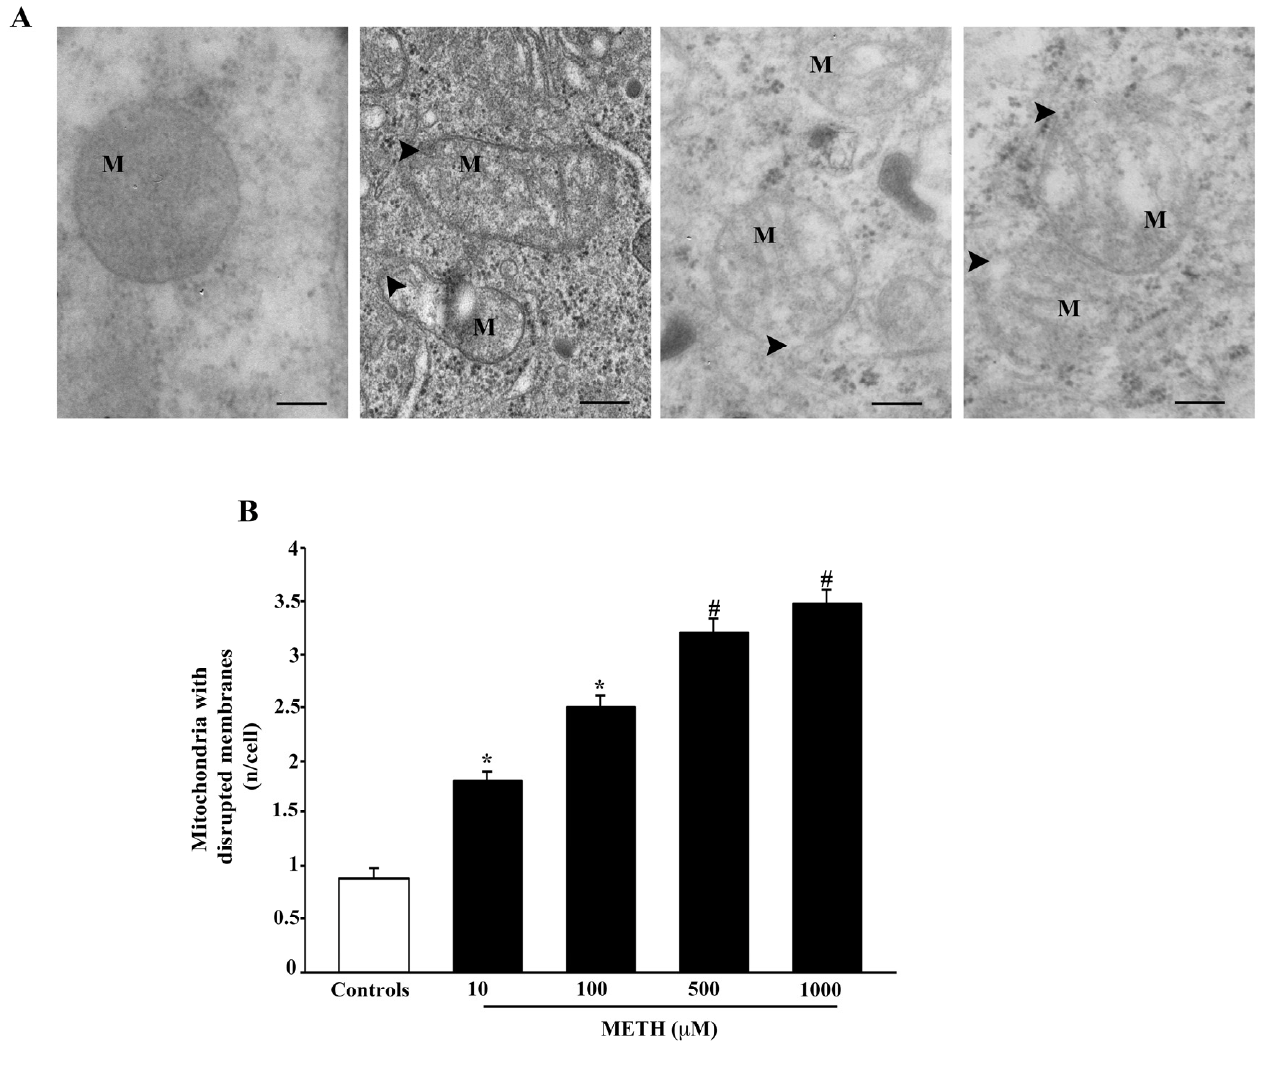
Figure 10. METH disrupts mitochondrial membranes. ( A ) Representative TEM micrographs showing that METH dose-dependently increases the ruptures of inner and outer membranes (arrowhead) of mitochondria (M). ( B ) The graph reports mitochondria with ruptured membranes. Values are given as the mean ± S.E.M from N = 50 cells per group. * p ≤ 0.05 compared with controls; # p ≤ 0.05 compared with controls and METH 10 µ M and 100 µ M. Scale bars = 160 nm.